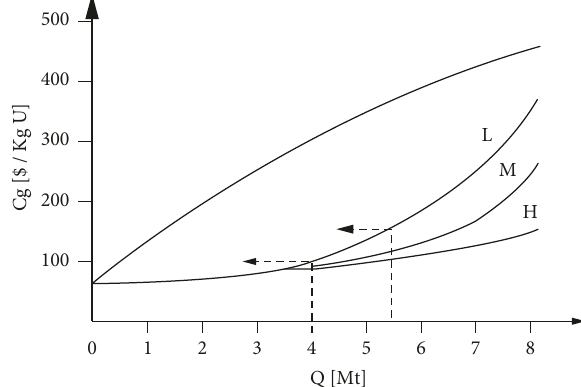
Figure 3: C ( τ ) versus Q ( τ ) plot. L M and H refer to low, medium g and high availabilities of